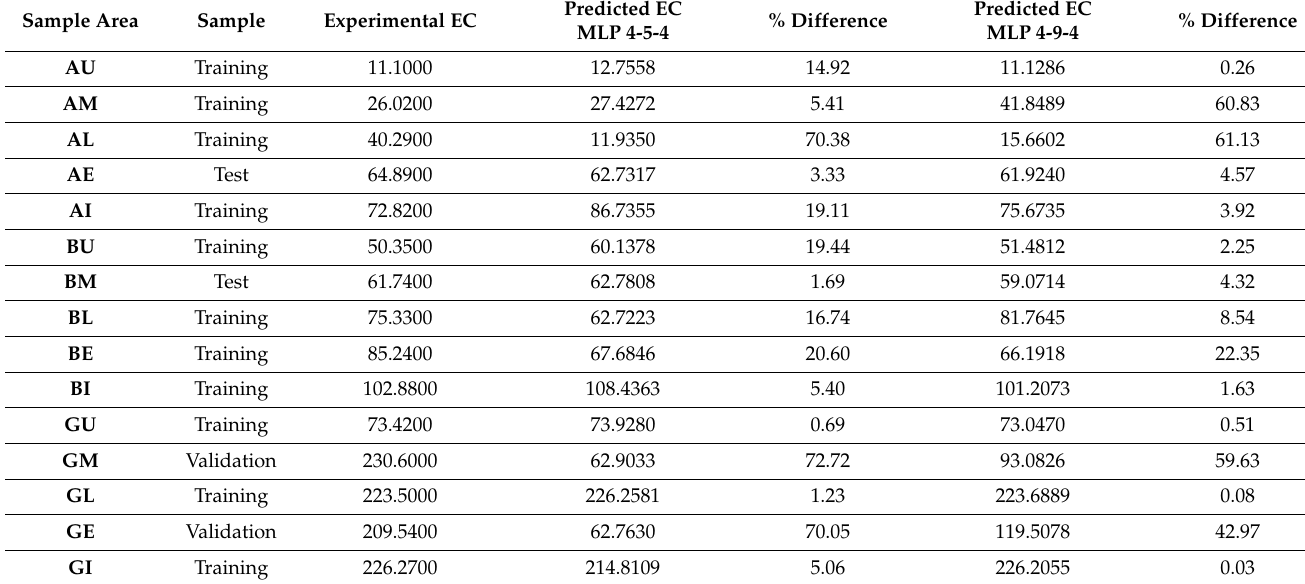
Table 5. Experimental and predicted values for pH generated by MLP 4-5-4 and MLP 4-9-4 networks. Sample: Training, Test,